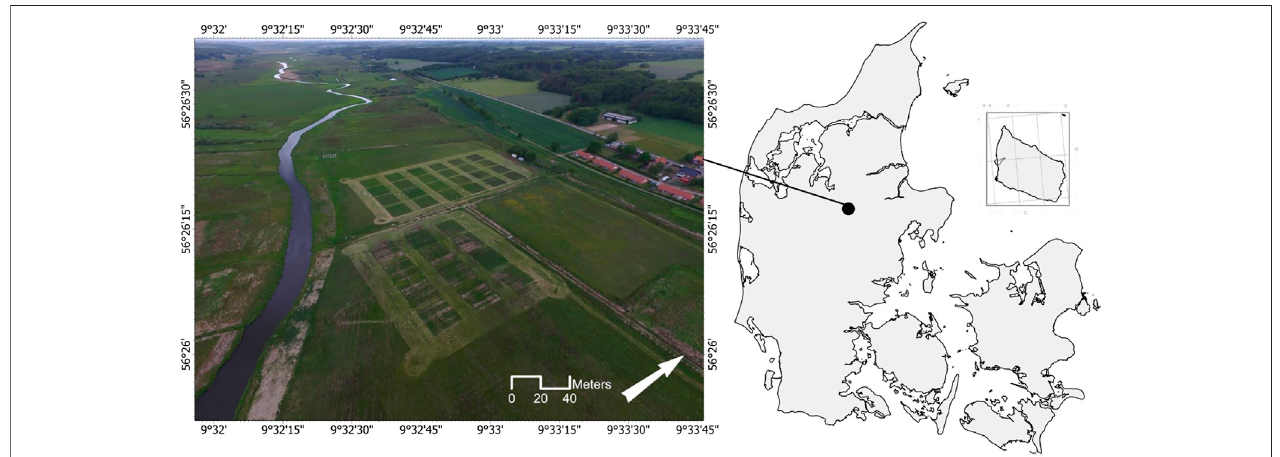
FIGURE 1 | Location of the study site in Denmark including aerial picture, taken in June